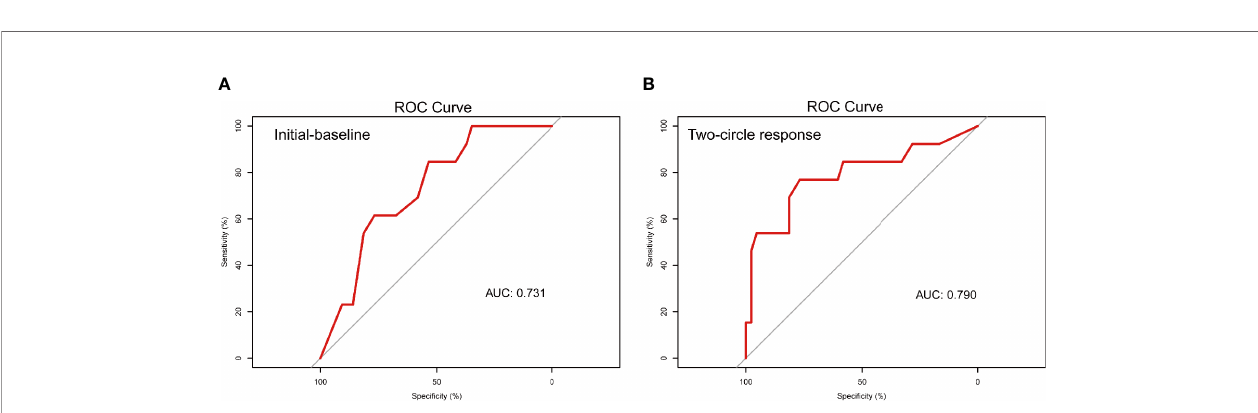
FIGURE 6 | Receiver operating characteristic curve of the nomogram integrating ultrasound and clinicopathological features for predicting pCR after NAC. The AUCs of the initial-baseline nomogram (A) and two-cycle response nomogram (B) were 0.73 and 0.79, respectively. NAC, neoadjuvant chemotherapy; pCR, pathological complete response; AUC, area under the curve.